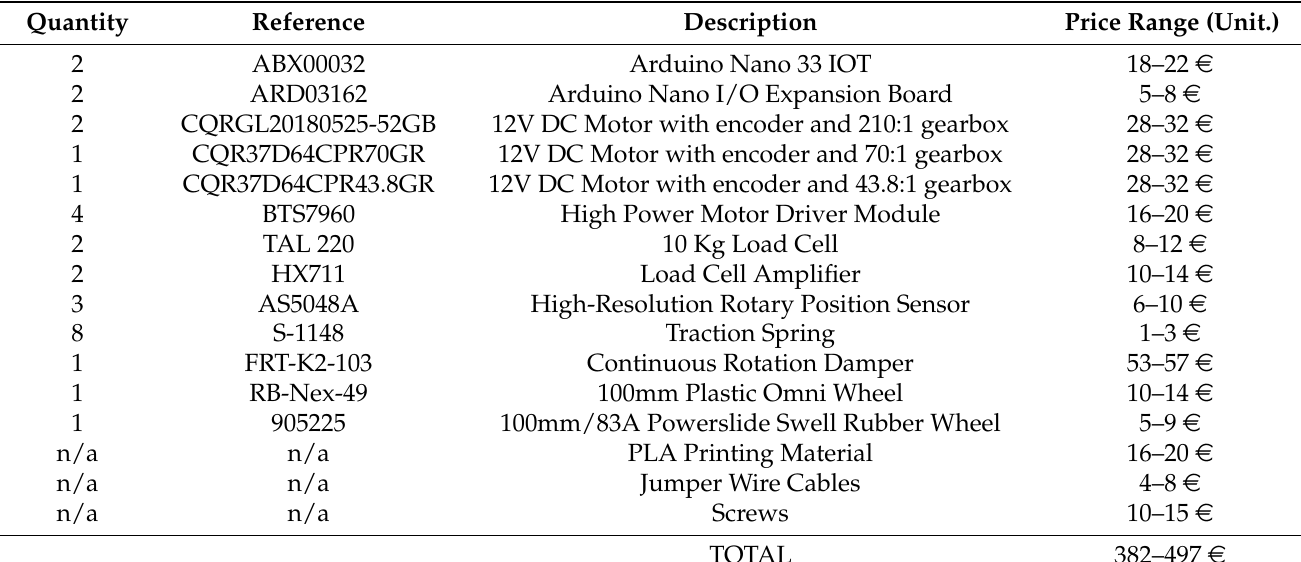
Table 1. Components and price range for the prototype